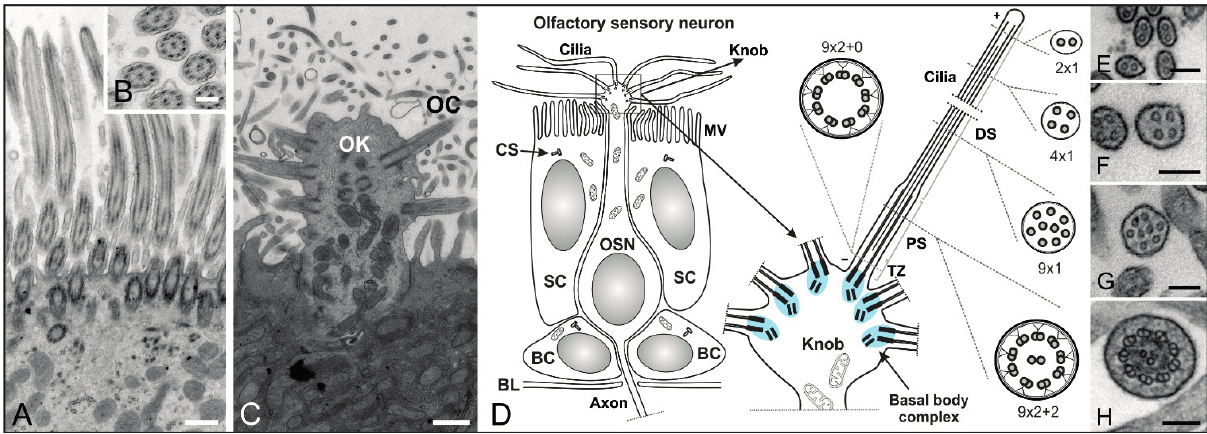
Figure 3. Structure of cilia in the mouse respiratory and olfactory epithelium. ( A – C ) Transmission electron micrographs of an adult mouse olfactory epithelium; ( A ) The respiratory epithelium contains multiple motile cilia on one cell; ( B ) Higher magnification of a cross section showing the (9 × 2 + 2) microtubule configuration of olfactory cilia; ( C ) Longitudinal section of an olfactory knob (OK) with extending olfactory cilia (OC); ( D ) Schematics of an olfactory sensory neuron (OSN) and its olfactory knob. OSNs are the receptor elements of the olfactory system. They are surrounded by supporting cells (SC) with a microvilli (MV) border on their apical surface and continually replaced by basal cells (BC) throughout life.